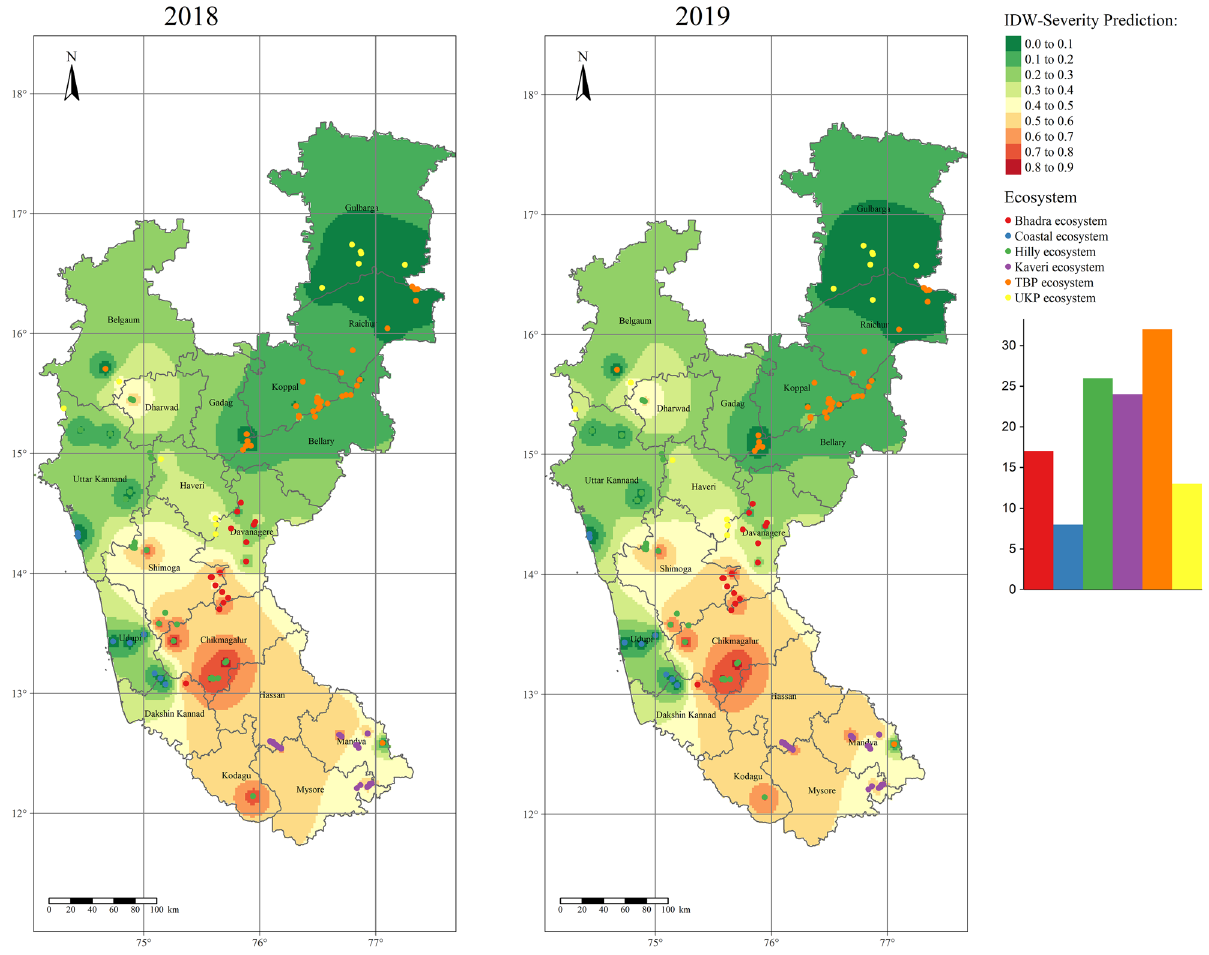
Figure 6. Interpolated disease severity maps of RBD were generated for 2018 and 2019 using the inverse distance weighted tool. Green to Red colors indicate lower to higher disease severity points in different rice ecosystems of Karnataka. The maps were created using R software (version